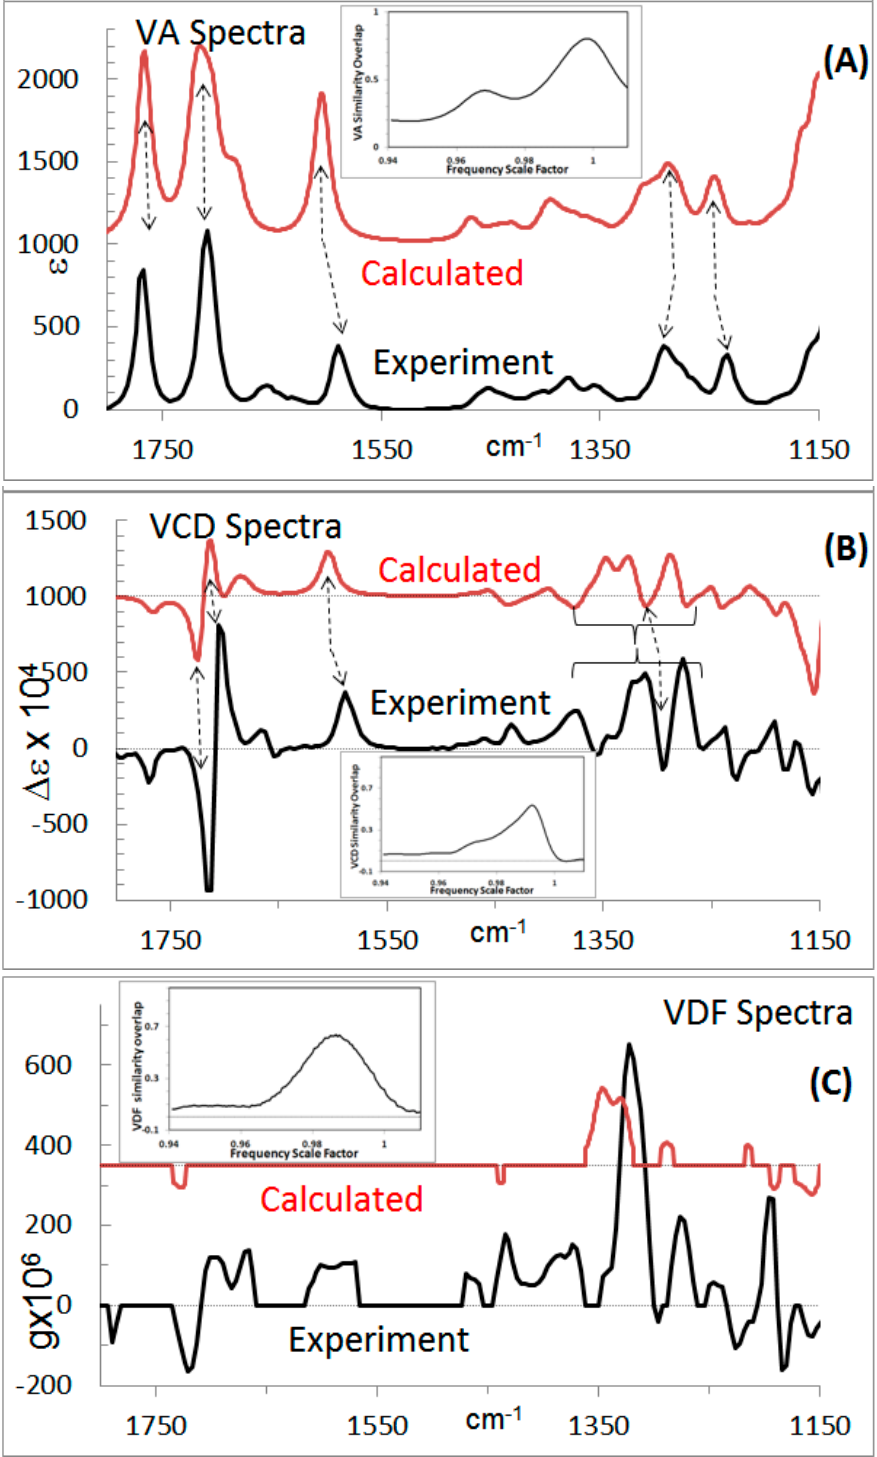
Figure 3. ( A ) Experimental and predicted vibrational absorption spectra. Inset shows the similarity overlap plot as a function of wavenumber scale factor; ( B ) experimental and predicted VCD spectra. Inset shows the similarity overlap plot as a function of wavenumber scale factor; ( C ) experimental and predicted VDF spectra. Inset shows the similarity overlap plot as a function of wavenumber scale factor. The experimental spectra are for ( − ) 589 -centratherin and predicted spectra are for (6 R ,7 R ,8 S ,10 R ,2’ Z ) structure. Data taken from Reference [26].